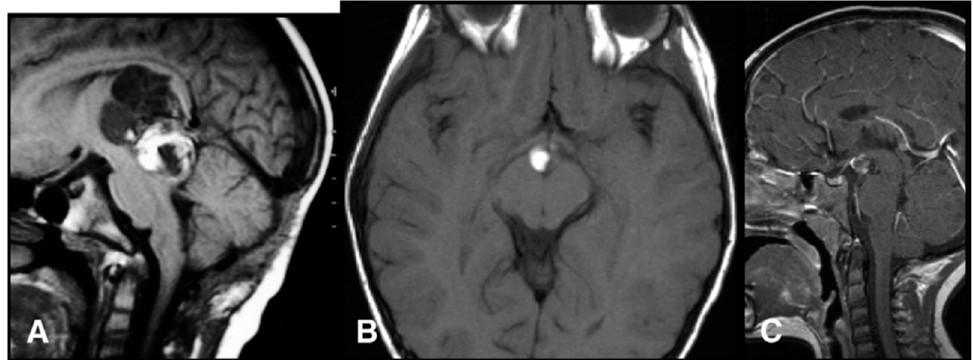
Figure 5. Pineal teratoma MRI. Sagittal T1 image ( A ), axial T1 ( B ) and sagittal contrast-enhanced T1 ( C ) images. Reprinted with permission from Peterson et al. (2012) [54]. Elsevier—2021 (License Number: 5034851378505).